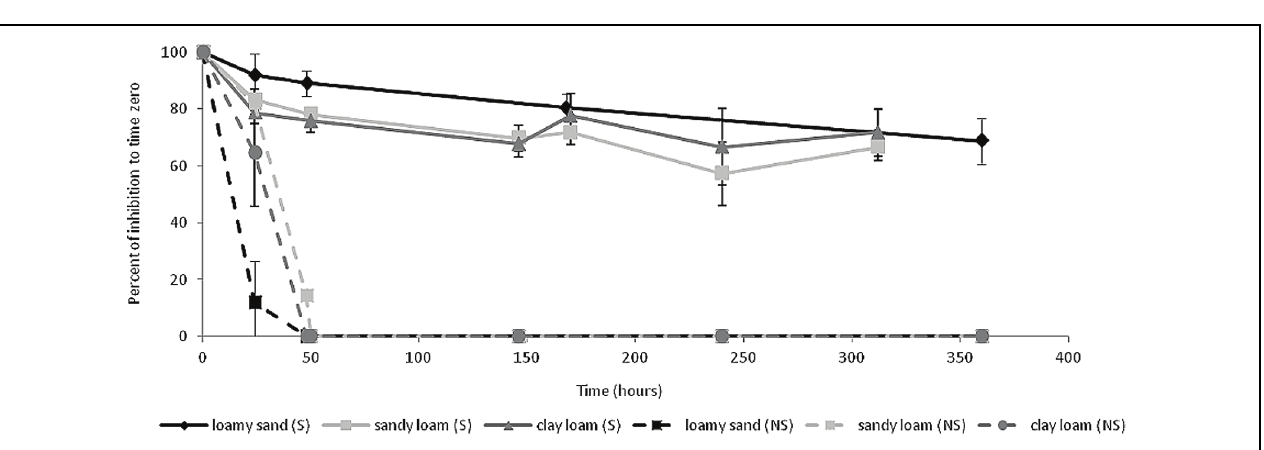
FIGURE 4 | Ceftriaxone activity in soil slurries. Black lines (Manoa soil), dark gray lines (Carmel soil) and light gray lines (Gilat soil). Soils are grouped into sterile soils (S, continuous lines) and non-sterile soils (NS, dashed